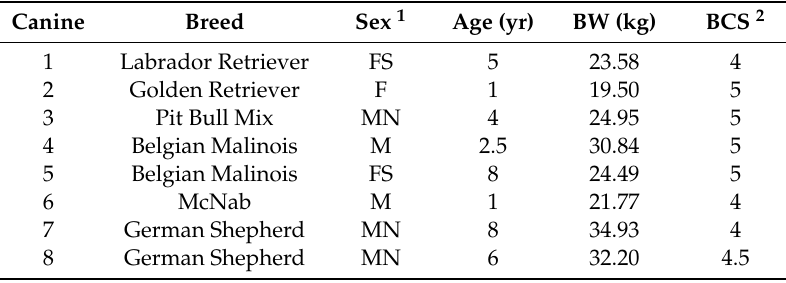
Table 1. Characteristic of human remains detection